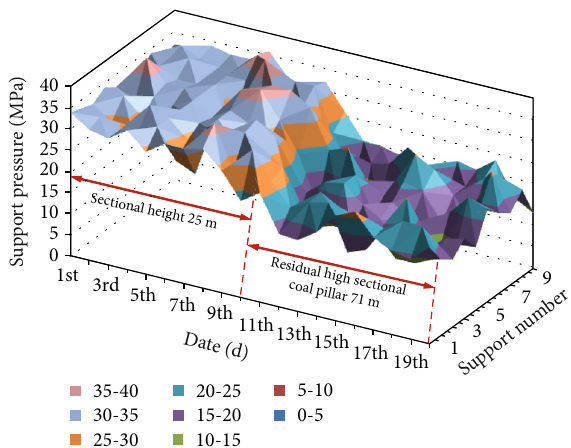
Figure 2: Characteristics of pressure change of hydraulic supports in the working